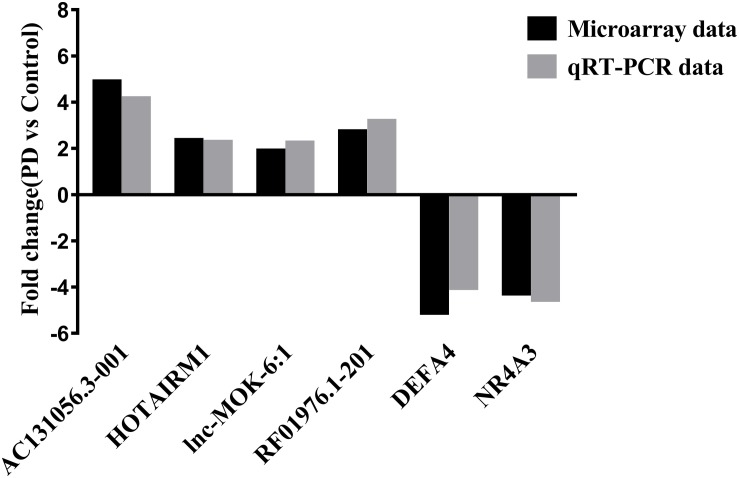
Validation of some of the differentially expressed lncRNAs and mRNAs. The upregulation of the lncRNAs AC131056.3-001, HOTAIRM1, lnc-MOK-6:1, RF01976.1-201, and the downregulation of the mRNA NR4A3 and DEFA4 in circulating leukocytes of PD patients (n = 5) compared to healthy controls (n = 5) were confirmed using quantitative PCR.